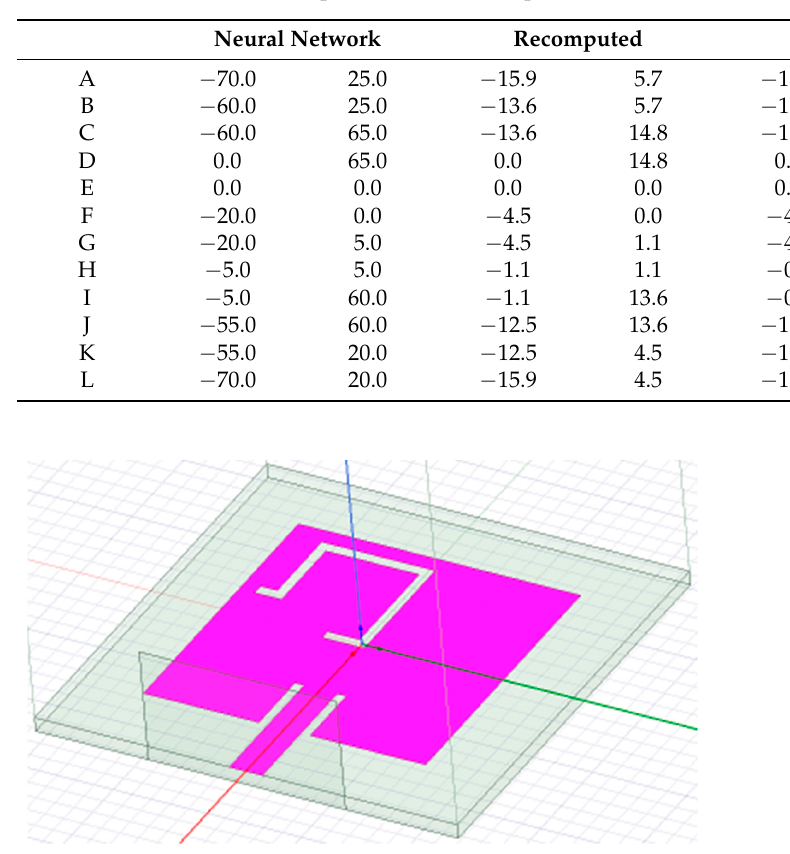
Figure 6. Numerical model of the G-slot antenna in HFSS. The patch is completed by a microstrip feeder and the wave port.